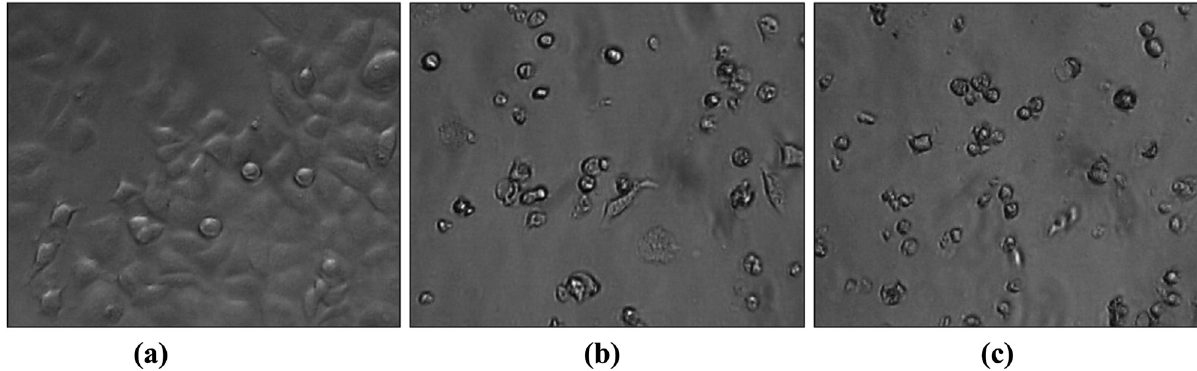
Figure 6: Morphological alterations observed in the untreated MCF - 7 cells ( a ) , treated with TecAn ( b ) , and PenAcAg ( c )